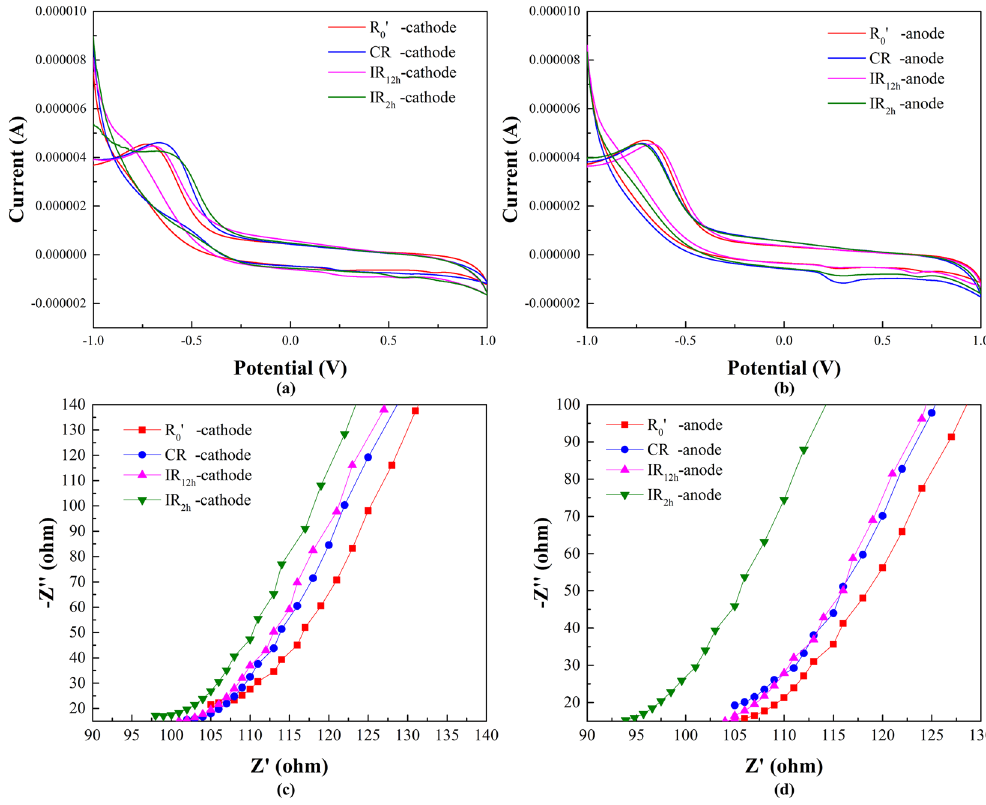
Figure 2. Electrochemical characterizations of the anode and cathode under different DC application modes. ( a ) Cyclic voltammograms (cathode); ( b ) Cyclic voltammograms (anode); ( c ) Electrochemical impedance spectroscopy (cathode); ( d ) Electrochemical impedance spectroscopy